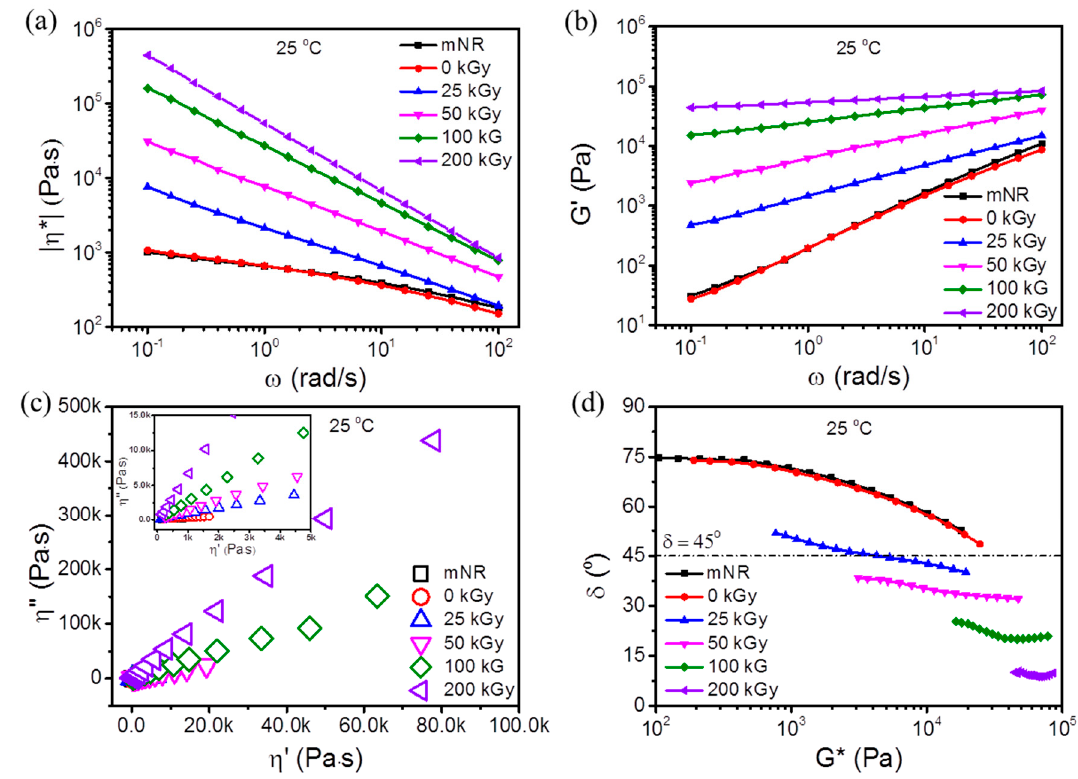
Figure 6. Rheology investigations: Effect of angular frequency on the complex viscosity ( a ) and storage modulus ( b ); Cole–cole plots ( c ) and van Gurpe-Palmen plots ( d ) for mNR samples EB modified at 25 °C.